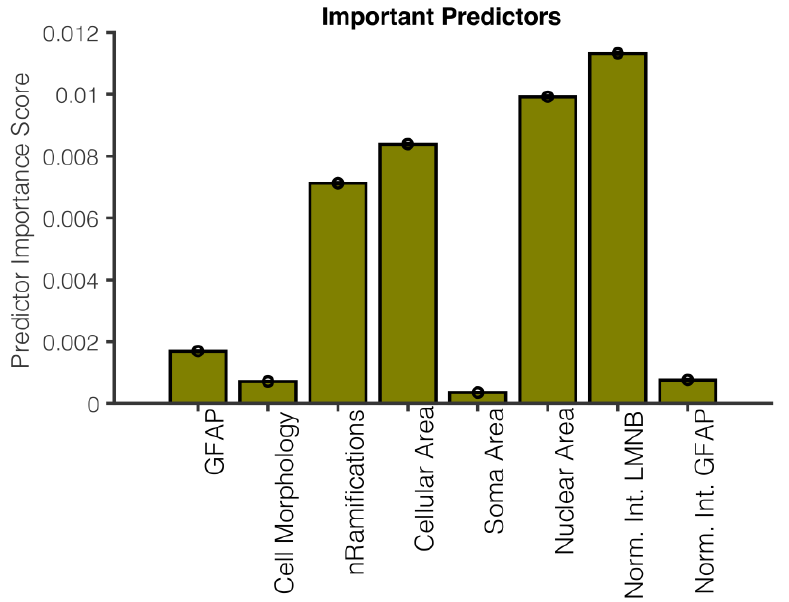
Figure 7. Bar graph showing the important predictors of a tree ensemble model cross-validated with LOOCV, Figure 5B. The x-axis represents the predictor variables, and the y-axis shows the importance score assigned to each predictor by the model.